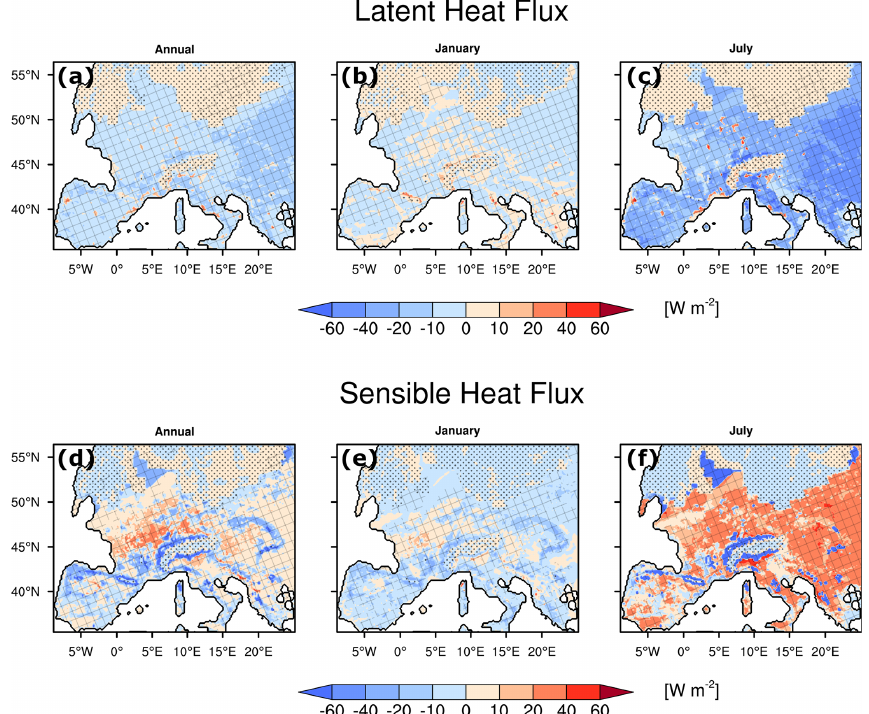
Figure 8. Atmospheric response to changes in the land cover. Panel (a) represents differences in the annual mean latent heat flux between LGM LGM – LGM PD . Panels (b) and (c) are the same as (a) but for January and July, respectively. Panels (d) , (e) , and (f) are the same as (a) , (b) , and (c) but for sensible heat flux. The solid line represents the coastline during the LGM, stippled areas are covered by glaciers, and crosshatched areas indicate statistically significant differences using a two-tailed bootstrappping technique with a 2% significance